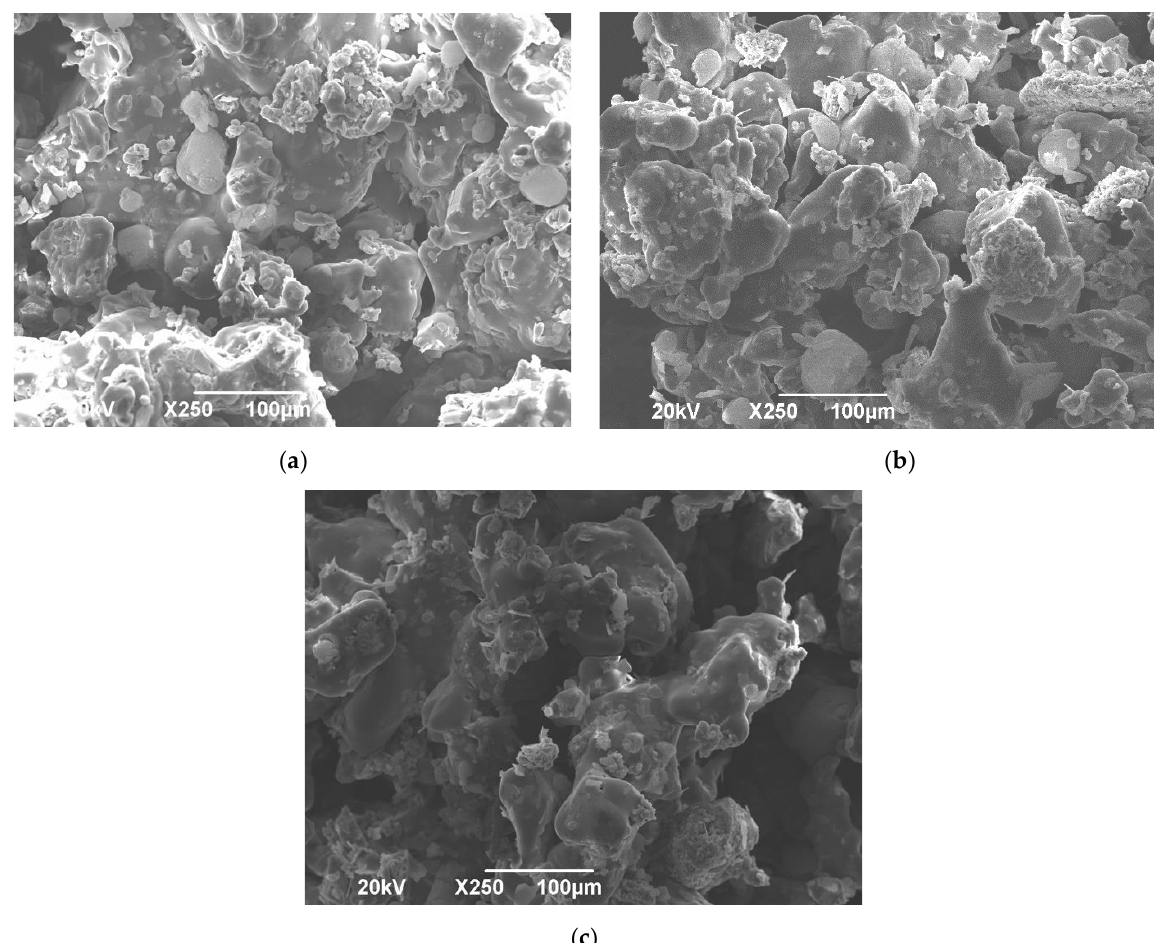
Figure 6. SEM micrographs of the cross-sectional view of irbesartan tablets ( a ) FH8 P1, ( b ) FH8 P2, and ( c ) FH8 P3.